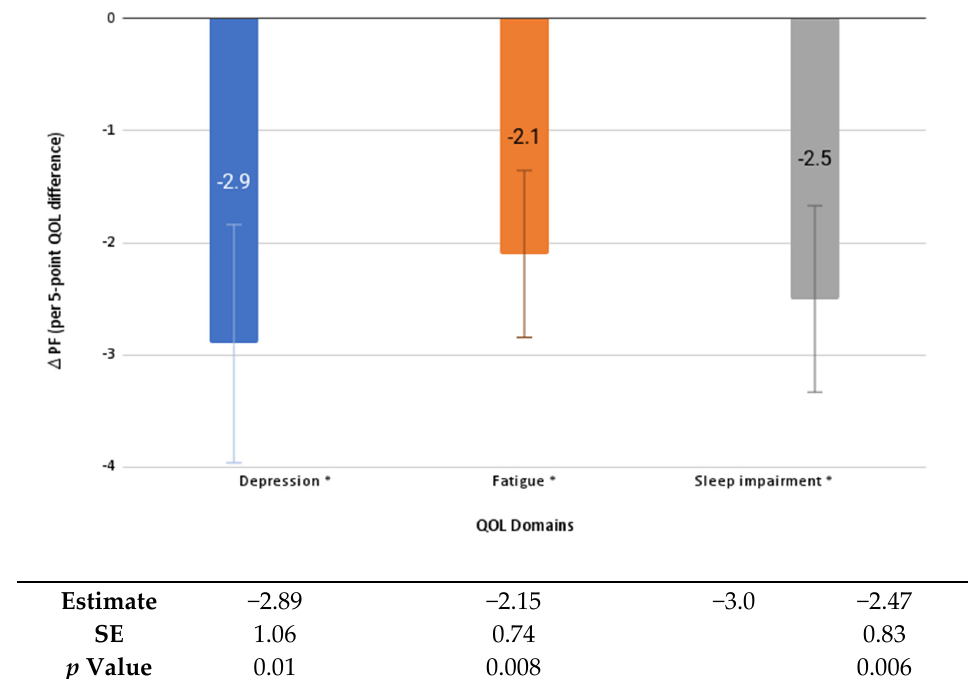
Figure 3. Changes in physical function from the six- to nine-month follow-up associated with five- point changes in QOL domains from baseline to the six-month follow up. Error bars indicate standard error; * indicates statistical significance ( p < 0.05). PF: physical function; QOL: quality of life; SE: standard error.